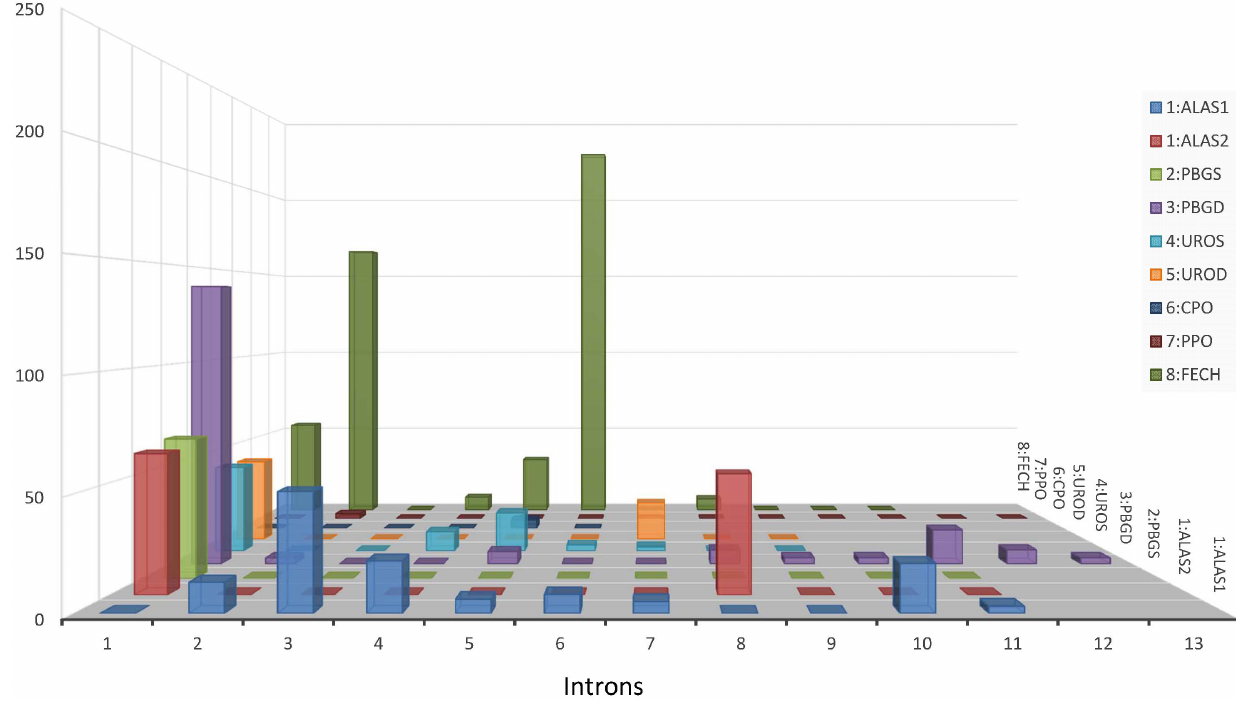
Figure 3. Three-dimensional view of the evolutionarily conserved DNase-hypersensitive sites in intron sequences. For each gene in the biosynthesis pathway (ALAS1 and ALAS2 are treated separately because they are different genes located on different chromosomes), the length of the intersection of the DNA sequence that is evolutionarily conserved across vertebrates and DNase-hypersensitive sites is indicated on the z-axis. The intron ID is provided on the x-axis. Genes from ALAS1 to FECH are shown on the y-axis and are coded from one to eight according to the linear order of the pathway. (Figure 1).